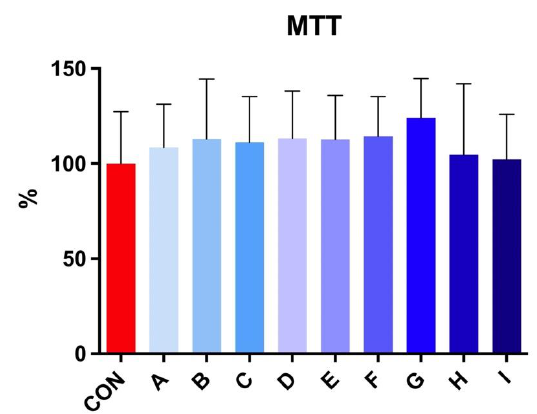
Figure 3. The effect of taurine and caffeine on the viability (%) of stallion spermatozoa after 30 h of incubation at 5 °C ( n = 10). CON: 0 mg/mL taurine + 0 mg/mL caffeine; A: 2.5 mg/mL taurine + 0.625 mg/mL caffeine; B: 2.5 mg/mL taurine + 1.25 mg/mL caffeine; C: 2.5 mg/mL taurine + 2.5 mg/mL caffeine; D: 5 mg/mL taurine + 0.625 mg/mL caffeine; E: 5 mg/mL taurine + 1.25 mg/mL caffeine; F: 5 mg/mL taurine + 2.5 mg/mL caffeine; G: 7.5 mg/mL taurine + 0.625 mg/mL caffeine; H: 7.5 mg/mL taurine + 1.25 mg/mL caffeine; I: 7.5 mg/mL taurine + 2.5 mg/mL caffeine. Each bar represents the mean value of observed samples (±SD).